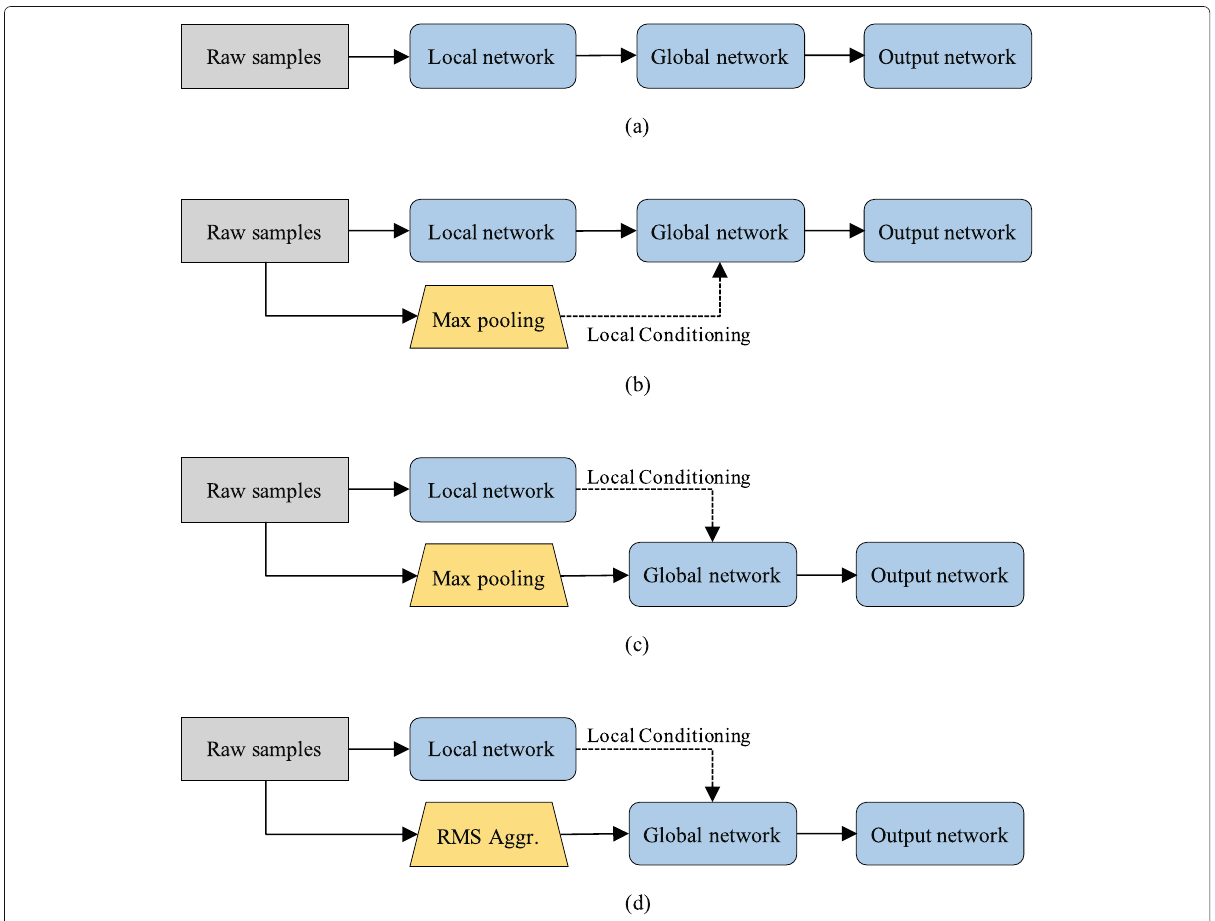
Fig. 4 The proposed model variations. a DiCCOSER. b DiCCOSER-CS-V2. c DiCCOSER-CS max. d DiCCOSER-CS rms. “RMS Aggr.” indicates using the RMS aggregation